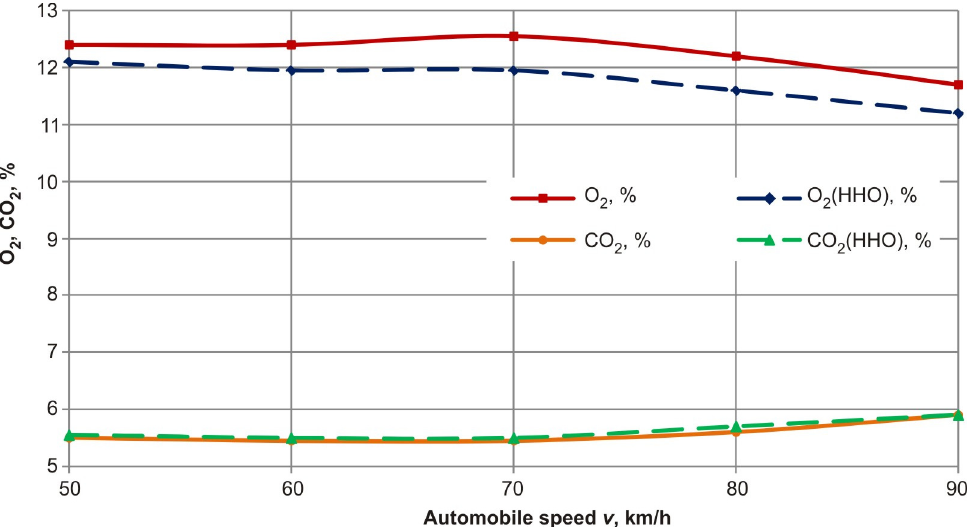
Fig. 3. Amounts of CO 2 and O 2 in exhaust